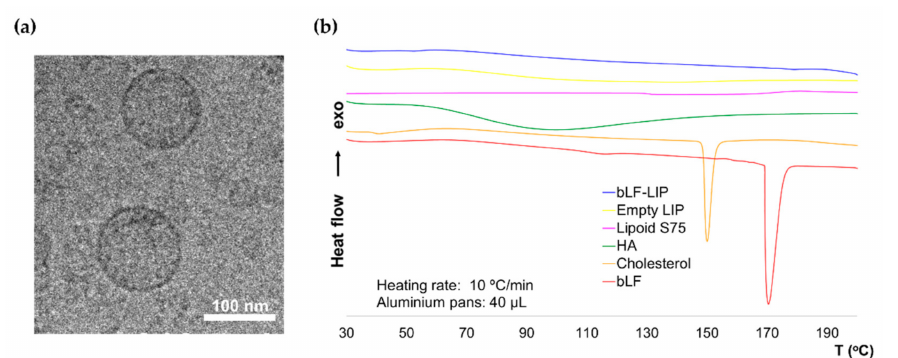
Figure 2. ( a ) Cryo-TEM image of bLF-LIP. ( b ) DSC thermograms of